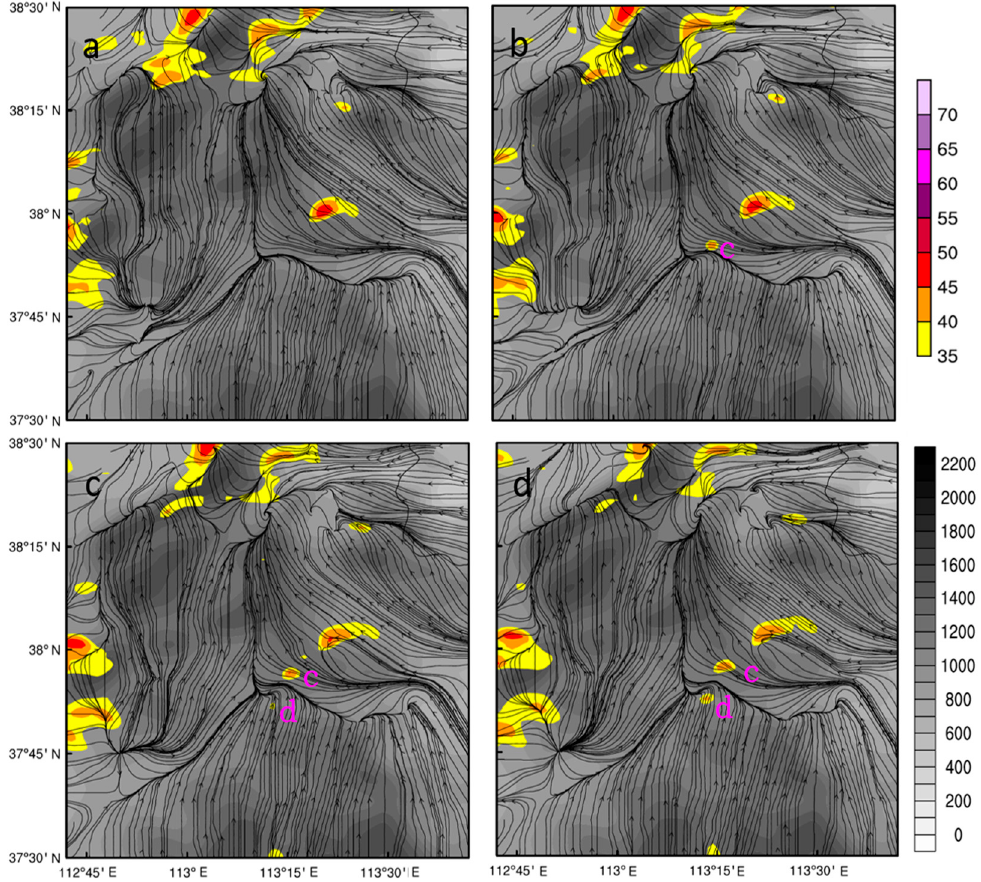
Figure 13. ( a – d ) Simulated composite radar reflectivity (color shaded, units: ≥ 35 dBZ), the topographic height (gray shaded, units: m), and the 10-m wind field (streamlines) during the evolution of convective cells ‘c’ and ‘d’ over the mountains at 0200, 0203, 0207, and 0210 UTC, respectively.